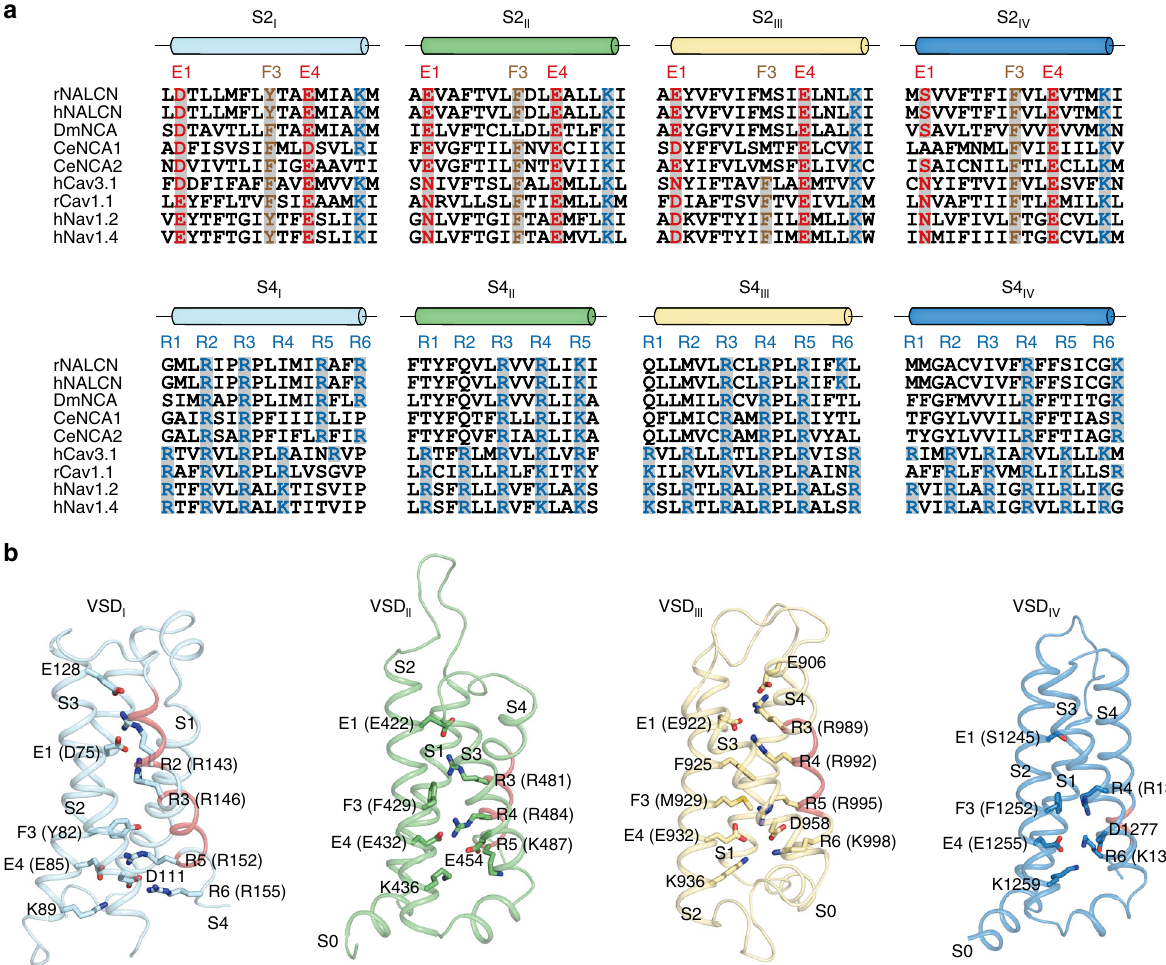
Fig. 4 Voltage sensors of NALCN at the depolarized state. a Sequence alignment of S2 and S4 segments. The sequences of rat NALCN, human NALCN, fruit fl y NCA, nematode NCA1, NCA2, human Ca V 3.1, rabbit Ca V 1.1, human Na V 1.2, and human Na V 1.4 were aligned using PROMALS3D 53 . Residues forming the charge-transfer center are shaded in gray. The conserved negative or polar E1 and E4 on S2 segments, F3 on S2 segments, and positive R1-R6 on S4 segments are highlighted in red, brown, and blue, respectively. b Structures of four VSDs in NALCN. Gating charges and charge-transfer center residues are shown as sticks. 3 10 helices are colored in